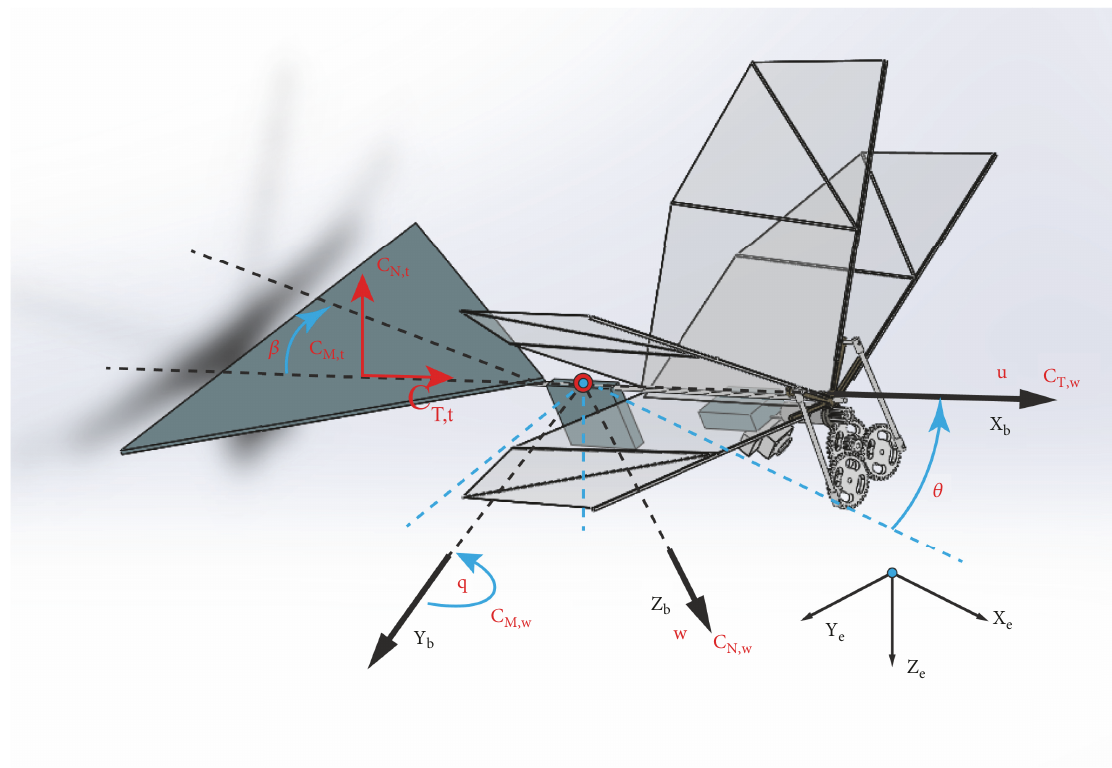
Figure 1: Diagram of the mechanism of tailed biplane FMAV and its parameter